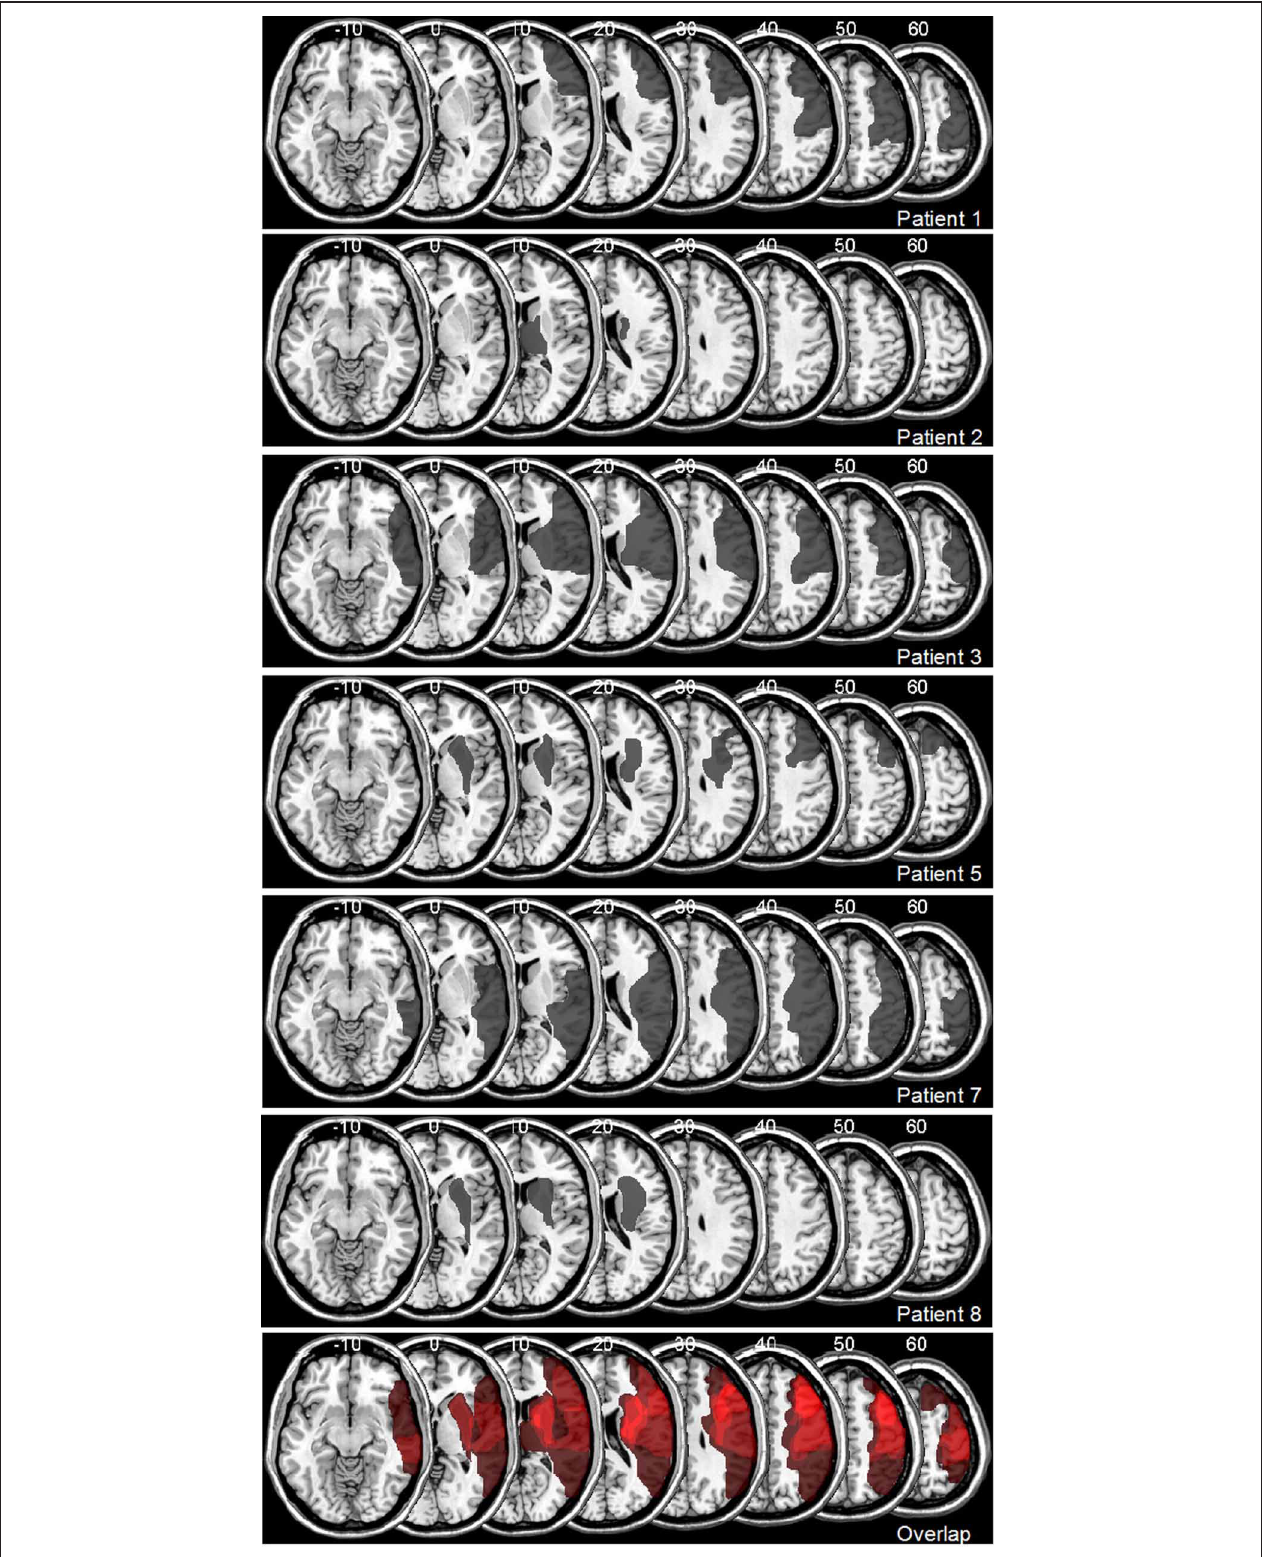
FIGURE 2 | Lesion Maps for 6 out of 8 Patients with Visuospatial Neglect, Plotted onto a Normal Template Brain Using MRIcro Software (Rorden and Brett, 2000). Affected areas (translucent gray) are plotted onto axial slices, with numbers indicating Z -coordinates in Talairach space.